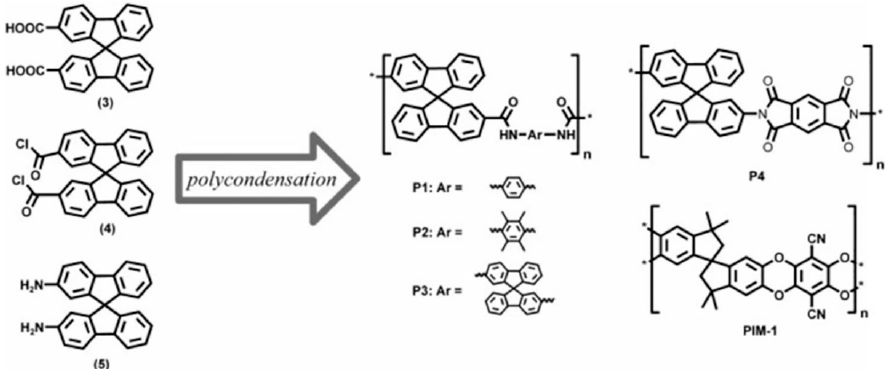
Figure 2. Chemical structures of the spirobifuorene monomers, the resulting poly(amide)s and poly(imide) P1–P4, and the repeating unit of PIM-1. Reproduced from Reference [41].